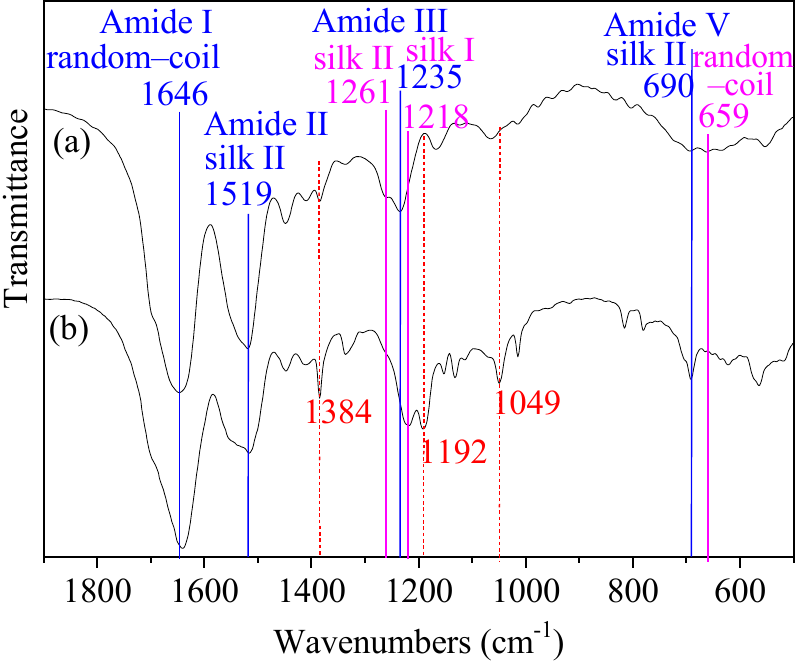
Figure 2. FTIR spectral changes between ( a ) SF and ( b ) SSF reflecting the changes of functional groups and the secondary structures of the protein upon modification.